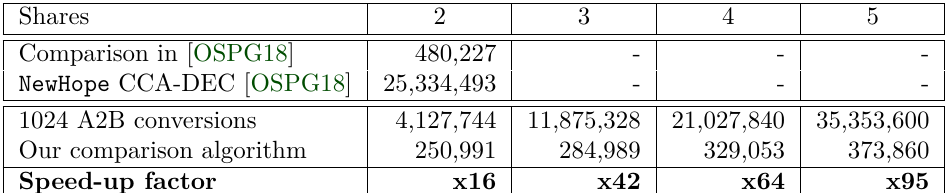
Table 1: Clock cycle counts for our ARM implementations of the masked comparison at 24 MHz for k = 1024 including randomness generation. All results are averaged over 100 runs.